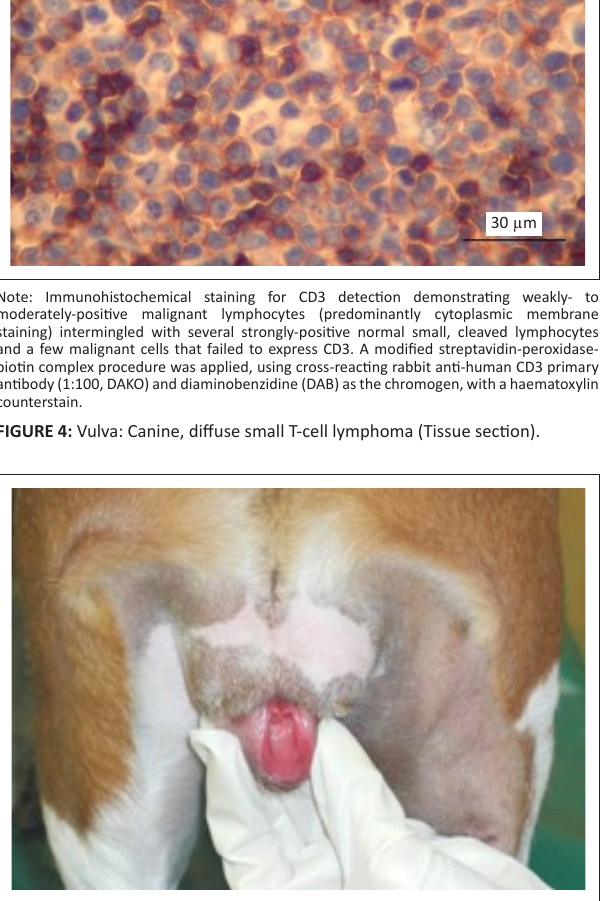
FIGURE 5: Photograph showing remission of clitoral lymphoma.